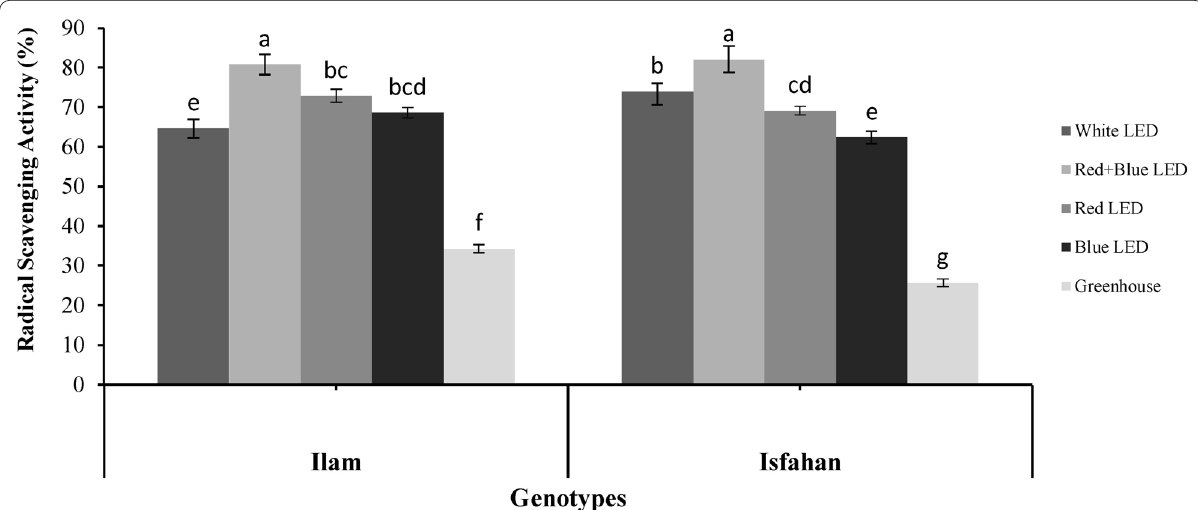
Fig. 1 Interaction of genotype*light on free radical scavenging activity in leaves of two genotypes of Melissa officinalis affected by different levels of light (non-identical letters indicate significant difference at 0.01 probability level of LSD